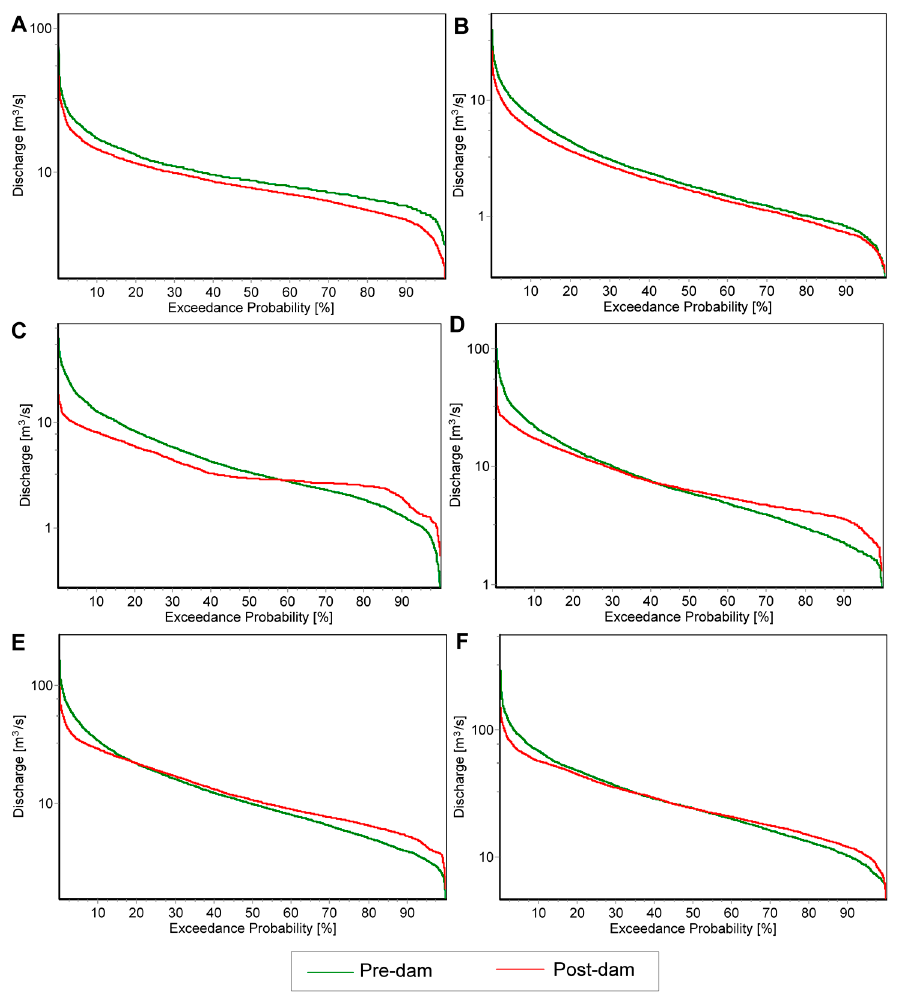
Figure 8. The changes in FDCs at selected gauge stations of the Upper Narew Catchment: ( A ) Fasty, ( B ) Narewka, ( C ) Bondary, ( D ) Narew, ( E ) Sura ż , and ( F ) Str ę kowa Góra. The discharge is presented on a logarithmic scale.